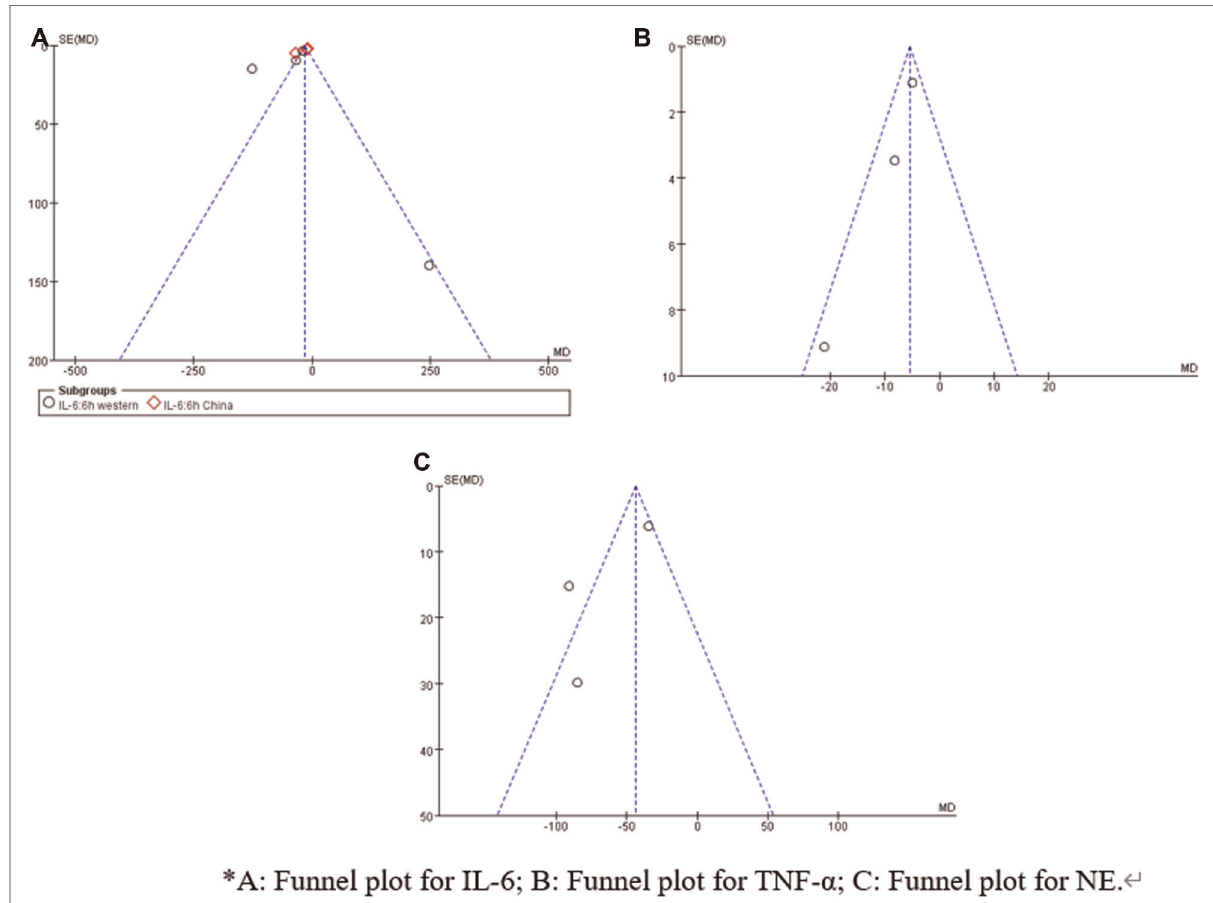
FIGURE 9 Funnel plot examination for postoperative 6 h in fl ammatory